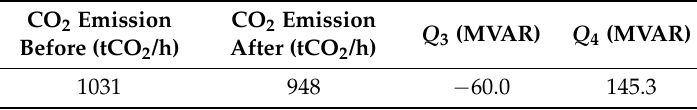
Table 9. Renewable reactive power control effects on greenhouse gas